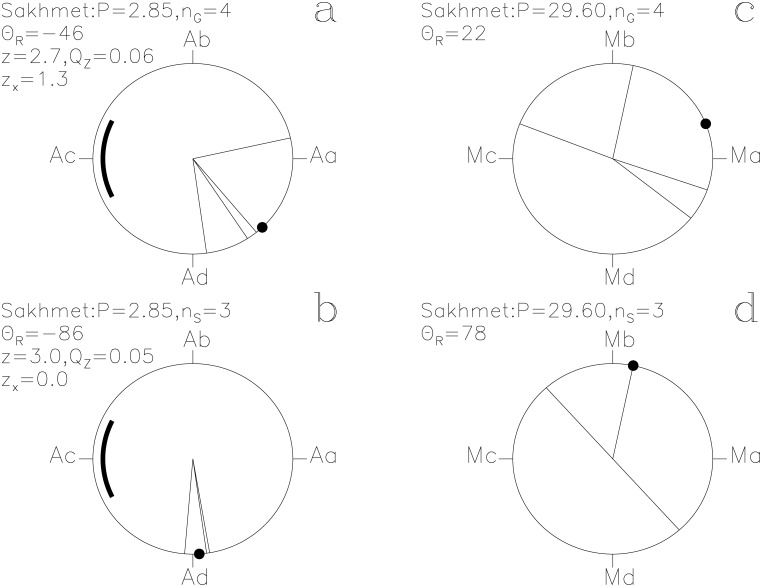
Sakhmet.otherwise as in Fig 1